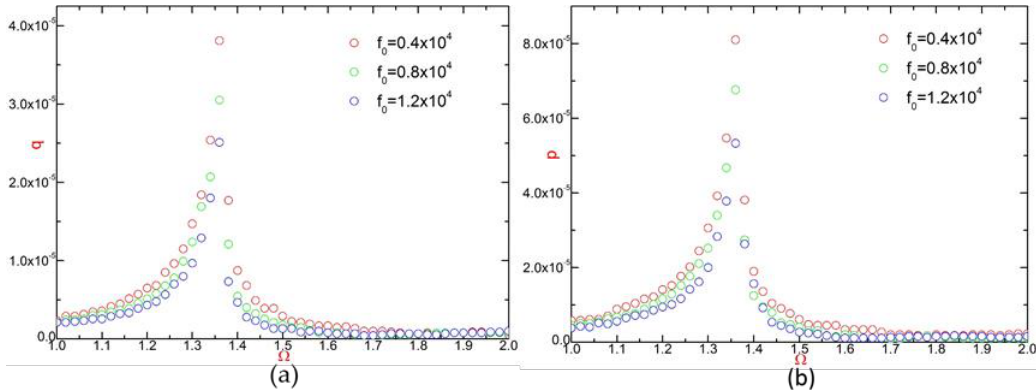
Figure 9. Influence of f 0 in 1st order generalized coodinate of the frequency response curve ( a ) in transvese direction ( b ) in rotation direction.